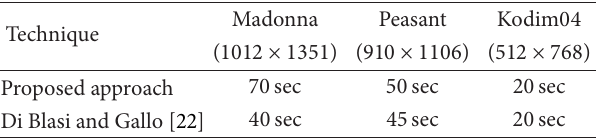
Table 2: Execution time (seconds) of the considered approaches on the test images employing tile cutting